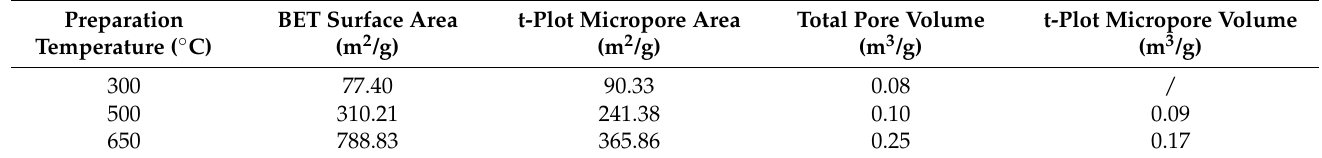
Table 2. Specific surface area and pore volume of GBB at different preparation temperatures.